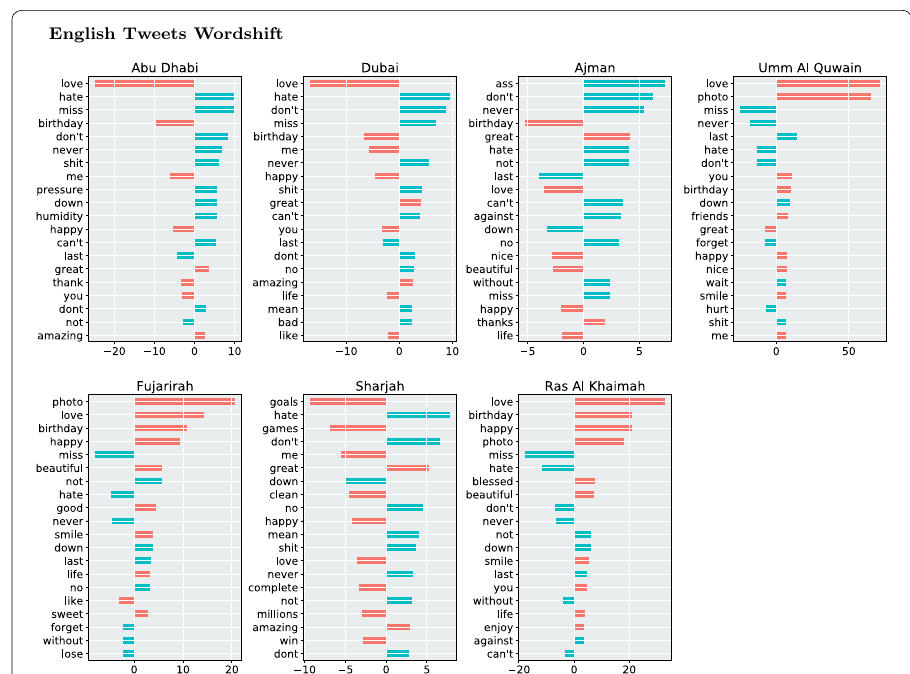
Fig. 5 English word shift graph (with reference to whole UAE) for the seven